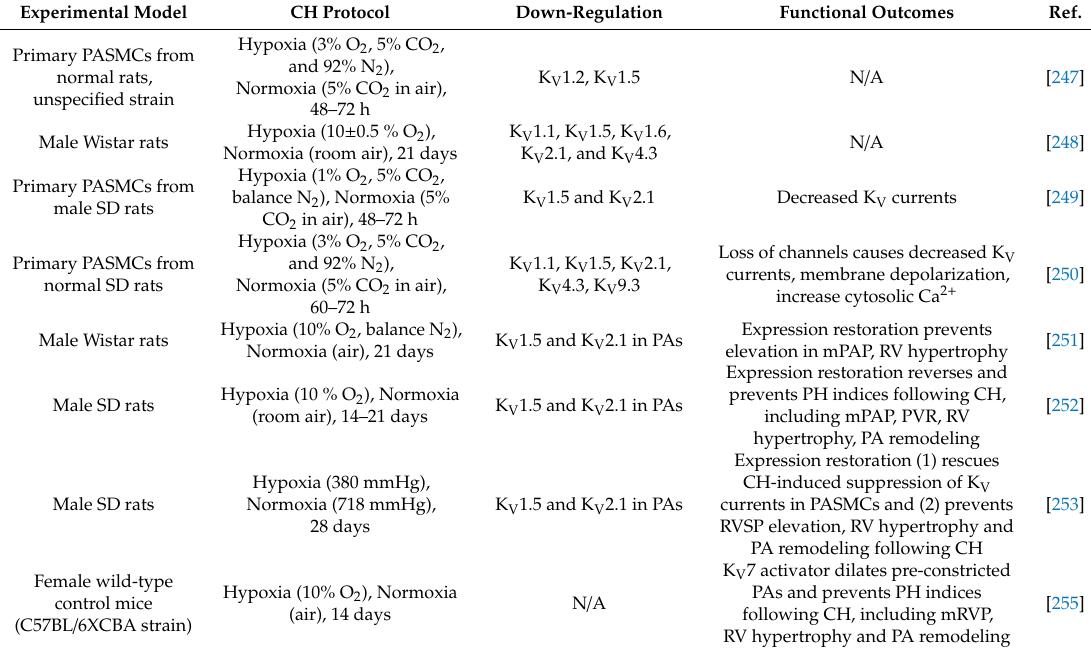
Table 3. Suppression of K V channels following CH exposure contributes to PH.